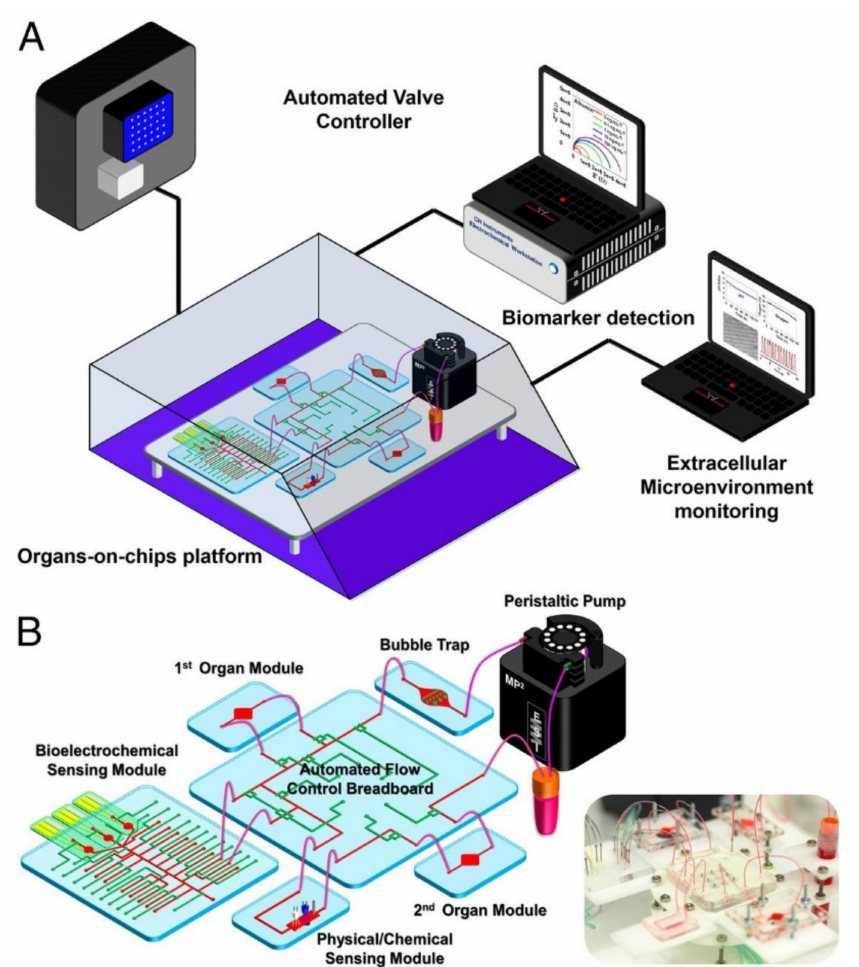
Figure 1. Multiorgan-on-a-chip platform with sensor systems, reproduced with permission from Ref. [31]. ( A ) The multiorgan-a-chip displaying the use of an incubator, pneumatic valve controlled that is automated, physical sensors operated by electronics, electrochemical signals measured by potentiostat, and a computer that analyzes commands. ( B ) The contents of the integrated microfluidic device, such as microbioreactors, reservoir, breadboard, bubble trap, electrochemical biosensors, and physical